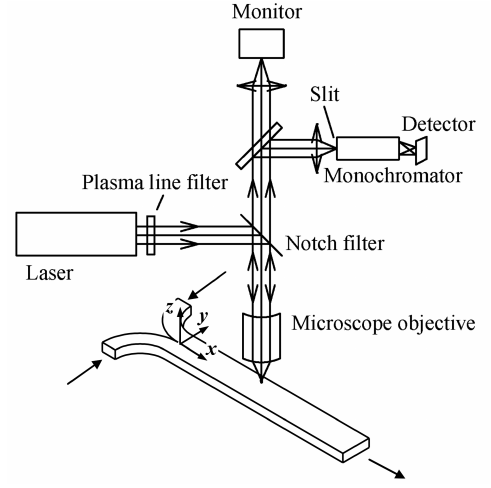
Figure 2. Schematic of the diffusion experiment system.